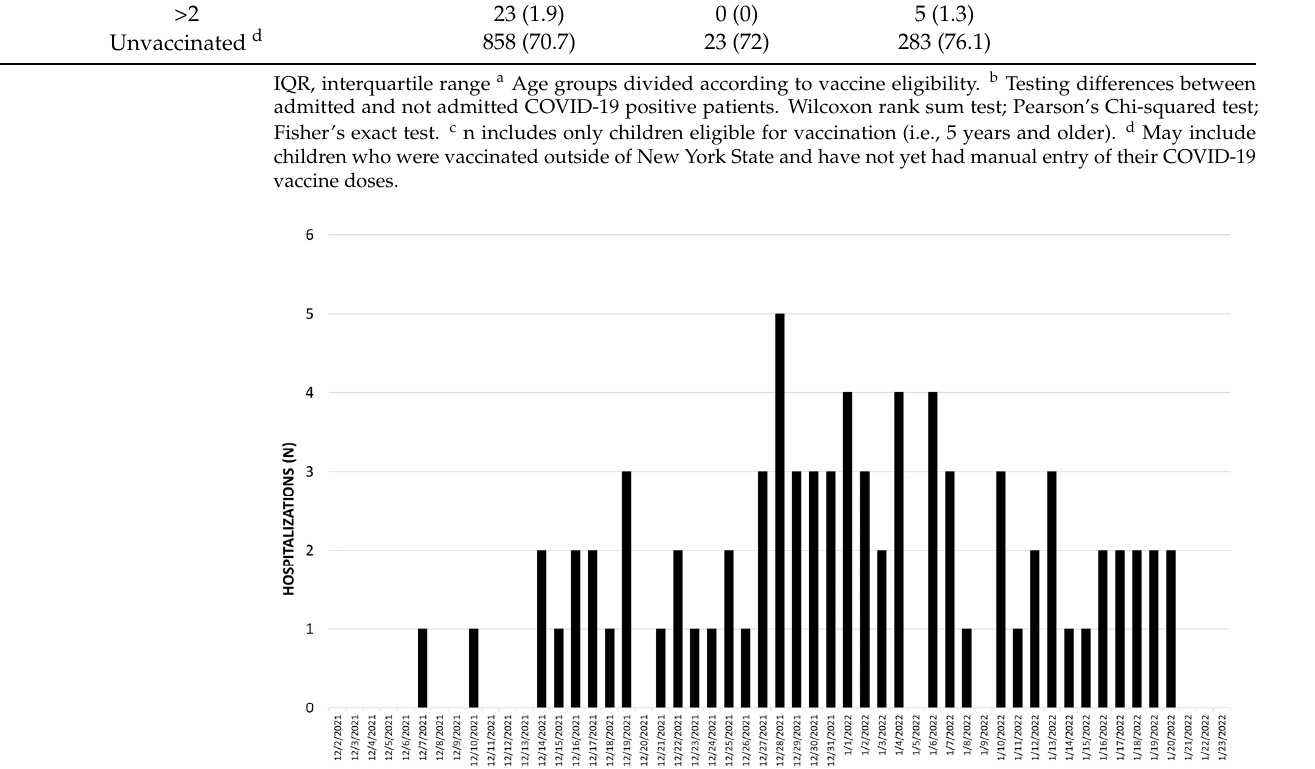
Figure 1. Number of COVID-19 positive hospitalizations per day from 2 December 2021 to 23 January 2022. Includes all children who tested positive for SARS-CoV-2 by RT-PCR and were hospitalized.